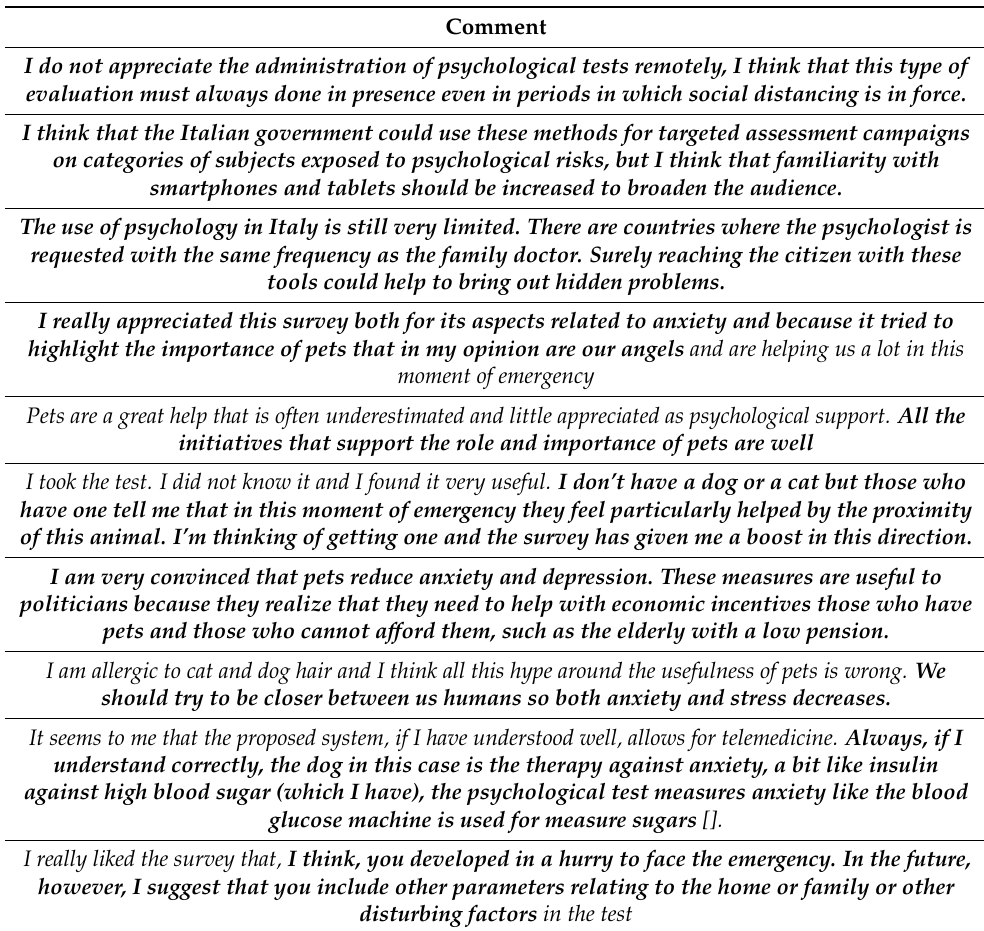
Table 2. Selected open answers.